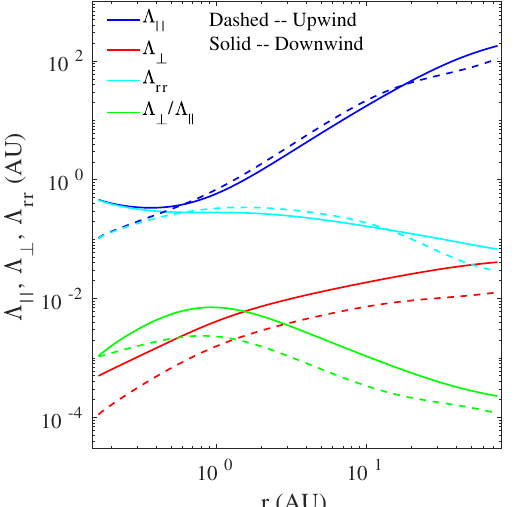
Figure 7. The radial evolution of the CR parallel Λ || (blue lines), perpendicular Λ ⊥ (red lines), and radial Λ rr (cyan lines) mean free path for a proton with rigidity of 445 MV for an outwardly directed IMF. It is assumed that the ratio of 2D fluctuating magnetic energy to slab fluctuating magnetic = 2 λ 2 D = 2 λ energy is 80:20 and λ slab b . The radial evolution of the fluctuating magnetic energy and b b the correlation length of magnetic field fluctuations are shown in the third row of Figure 2 and the middle panel of Figure 4,